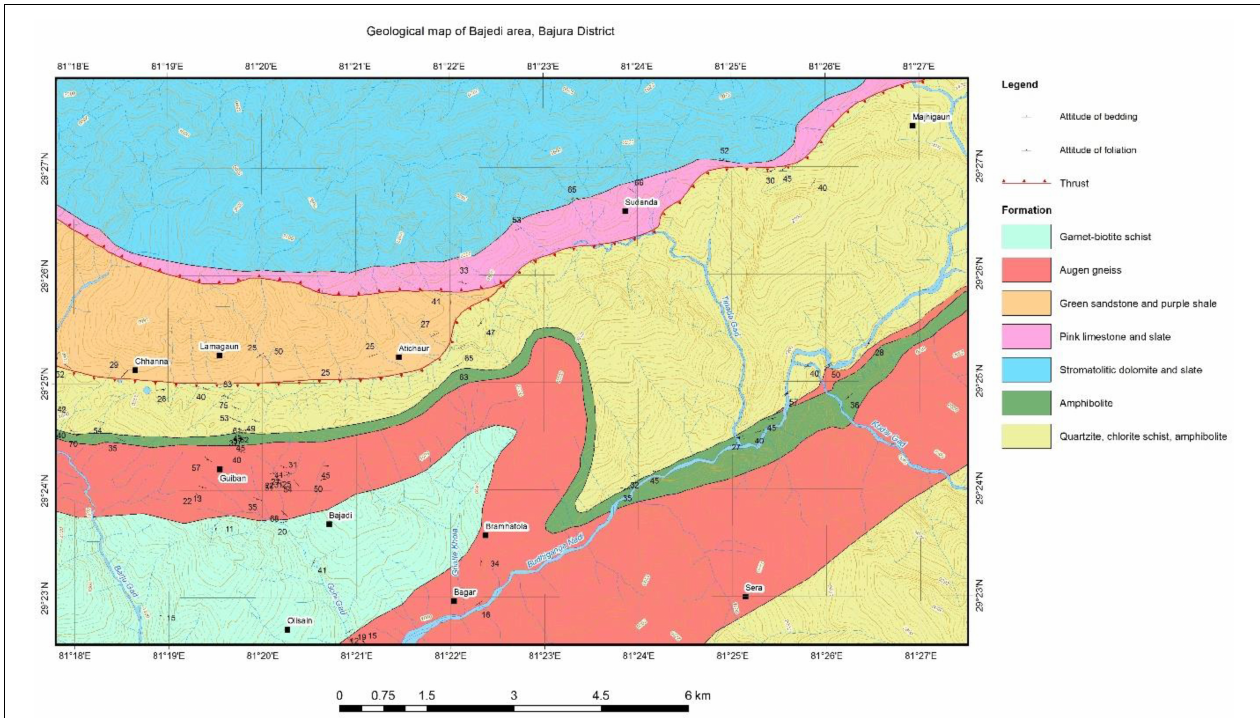
FIGURE 4 | Geological map of Bajedi are its surrounding region in Bajura District. Source: Field